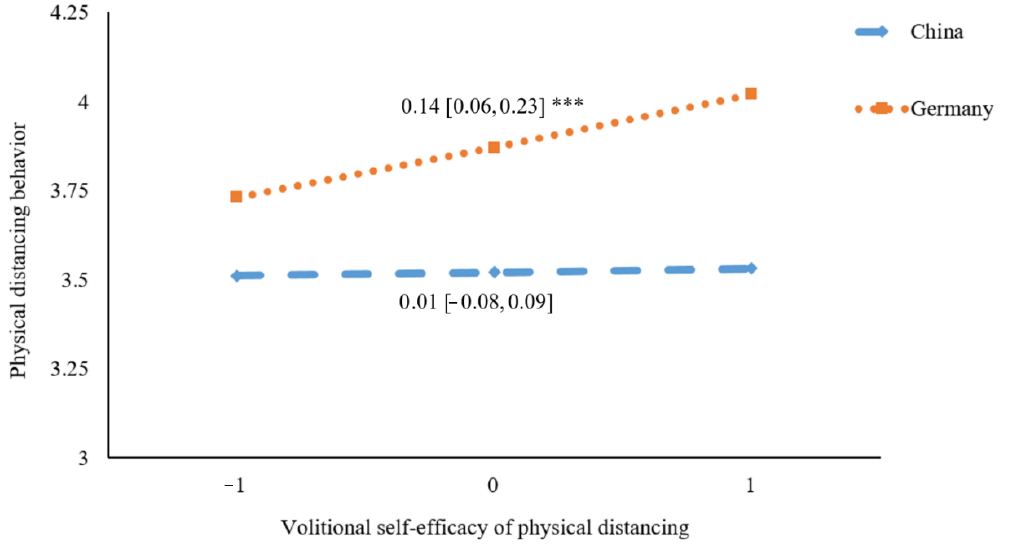
Figure 4. Plot of simple slopes showing the association between volitional self-efficacy and physical distancing at different countries ( n = 578); *** p < 0.001.